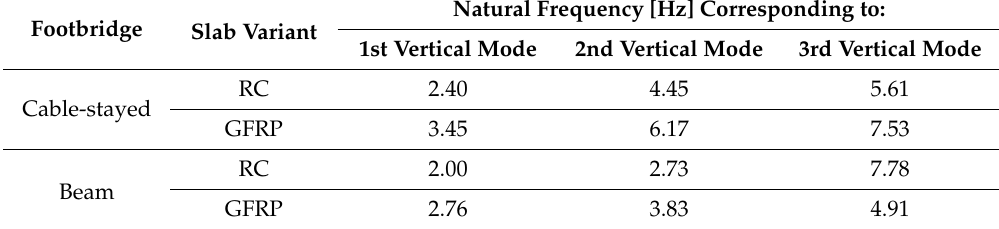
Table 6. Comparison of natural frequencies of the cable-stayed and the beam footbridges with the RC and GFRP slabs, corresponding to basic vertical